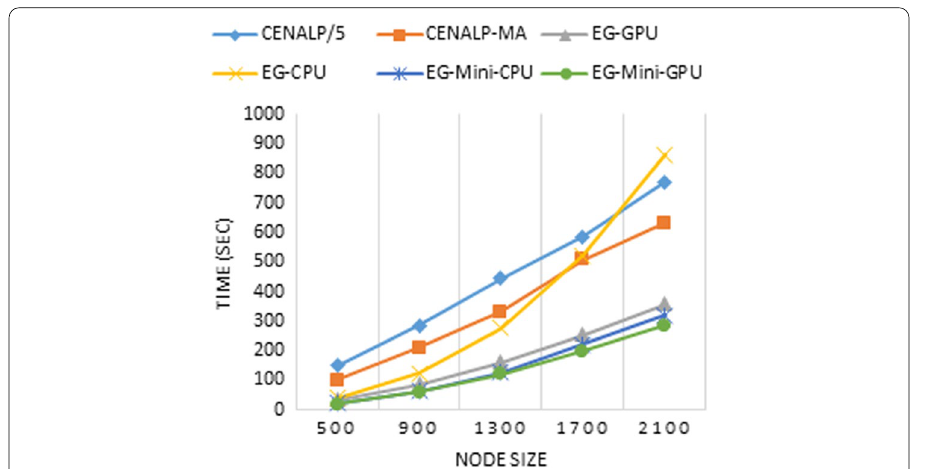
Fig. 8 Evaluate time vs. Network